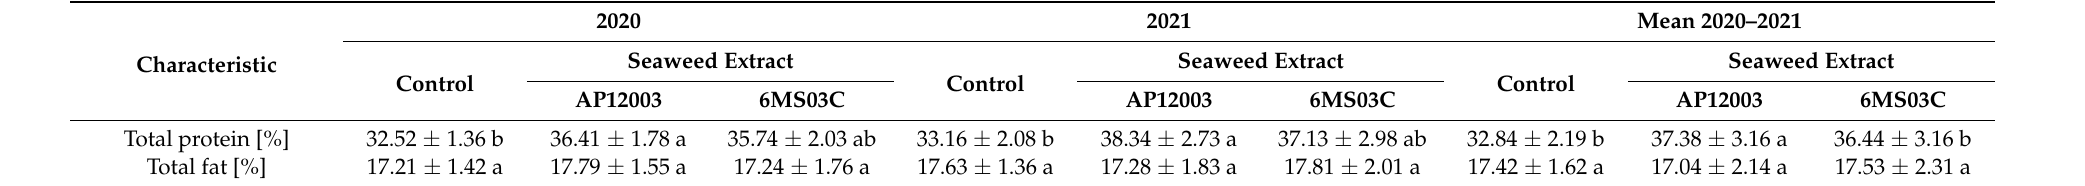
Values not sharing a common letter indicate significant difference at p ≤